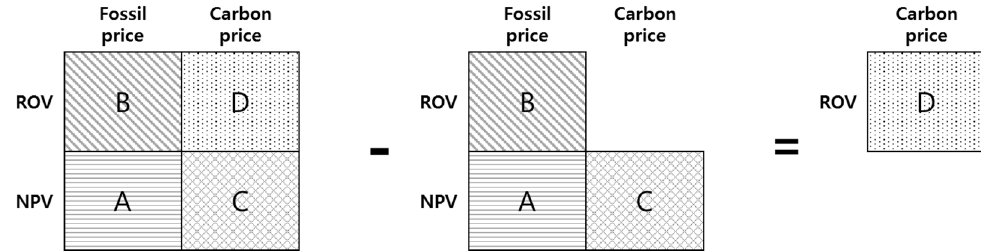
ff ects of carbon market uncertainty.